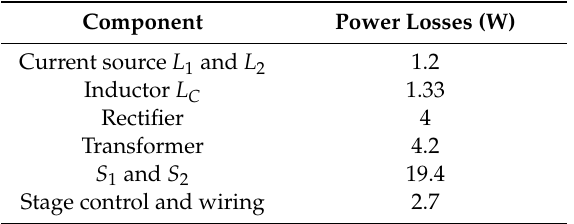
Table 5. Total power losses distribution by applying Si power